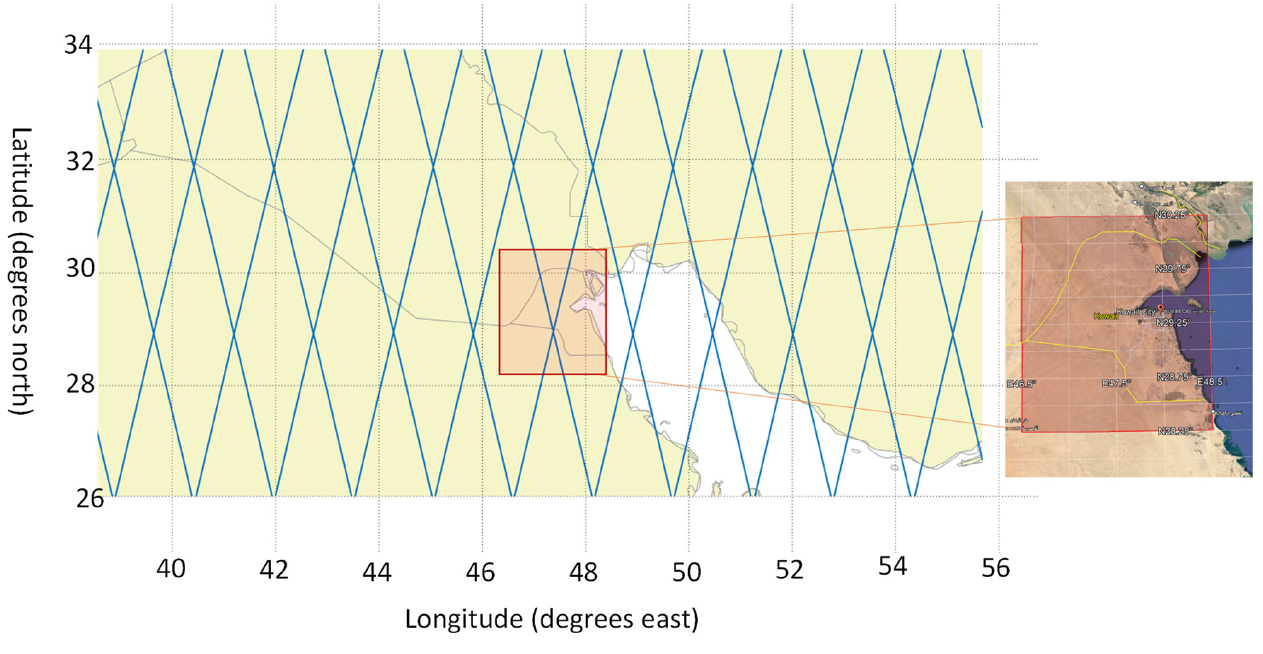
Figure 2. CALIPSO 16-day repeat ground tracks near Kuwait City. The orange box denotes the region of study centered near Kuwait City center.